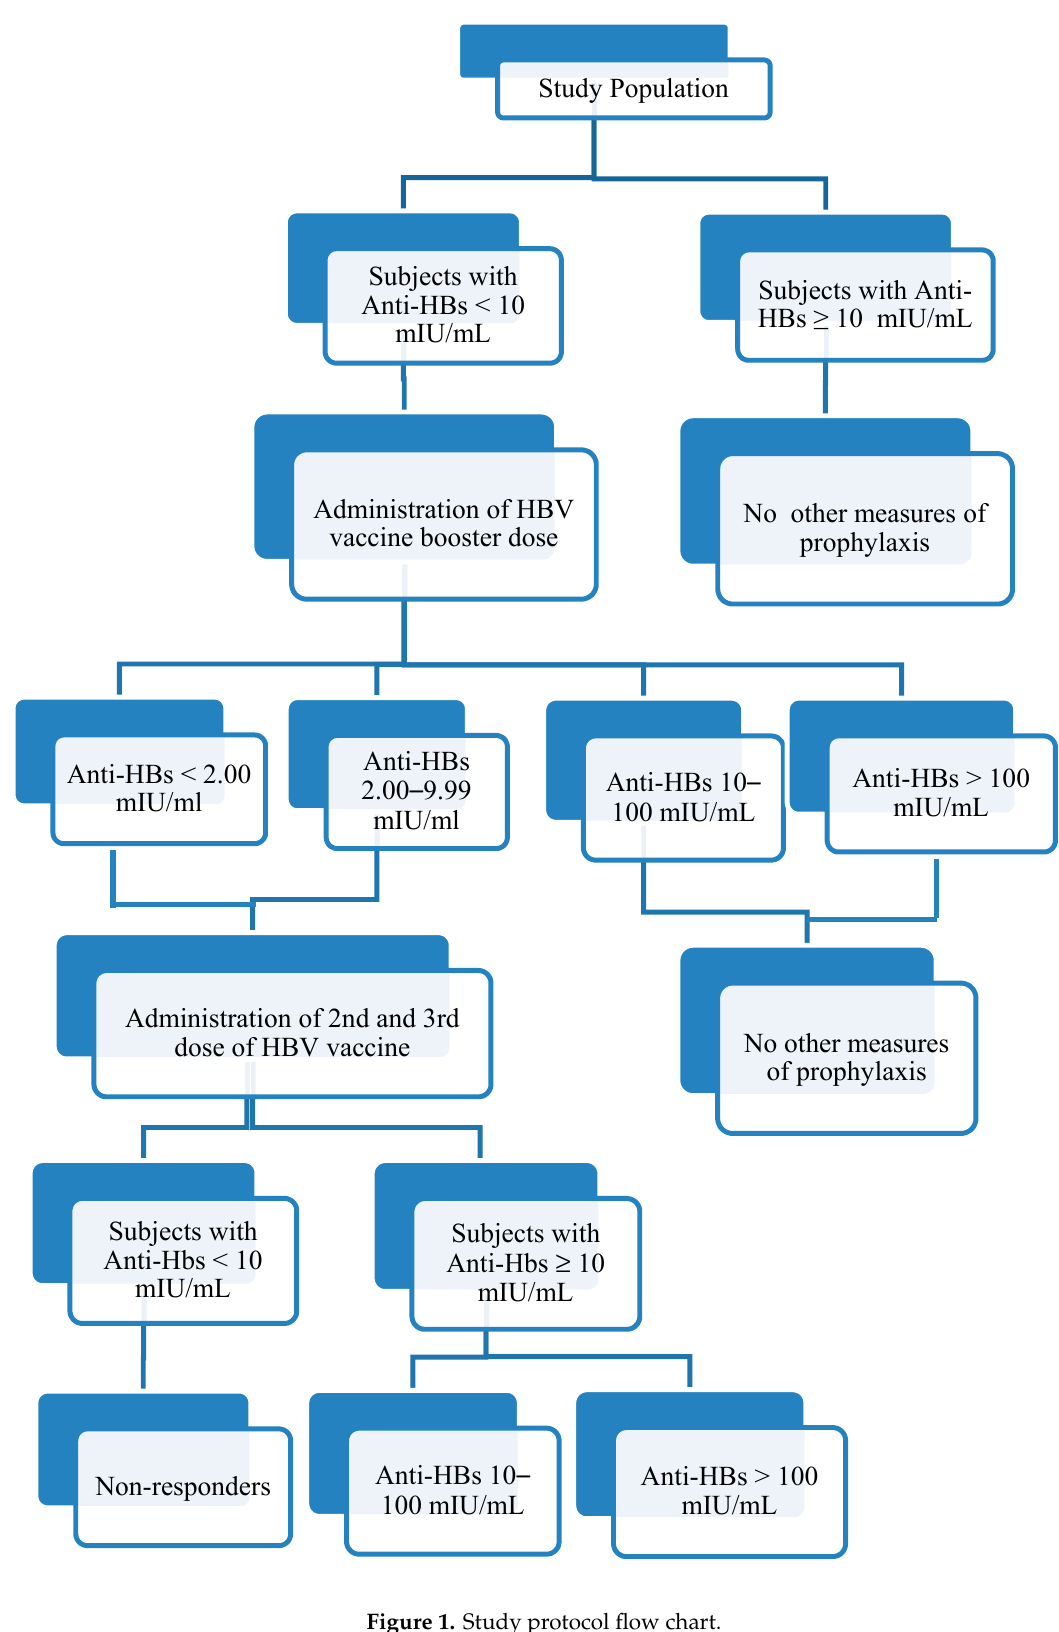
Figure 1. Study protocol flow chart.